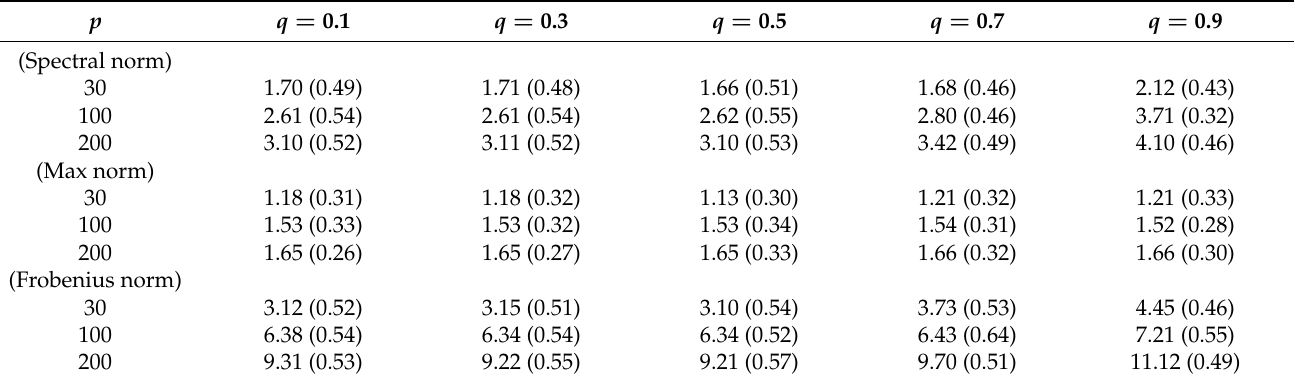
Table 5. Simulation results of the L q -CSCE with different q for Model 1 over 100 replications. The standard errors are given in parentheses.